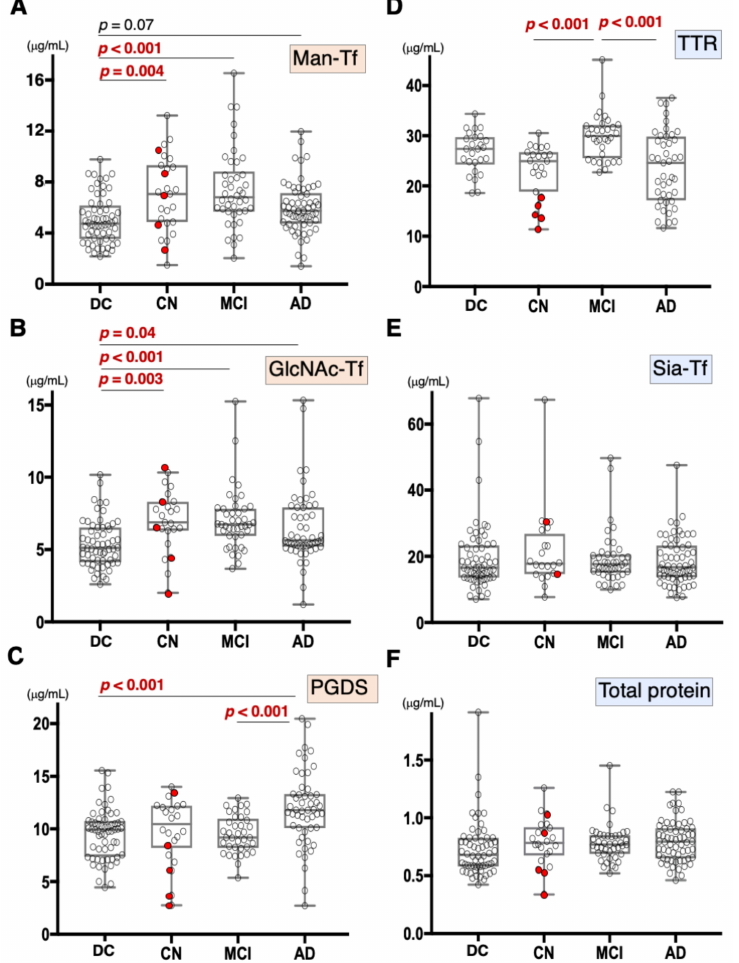
Figure 2. Box plots of CSF marker concentrations in CN, MCI, AD, and disease control (DC), which includes FTD, PSP, DLB, and PD: Man-Tf ( A ), GlcNAc-Tf ( B ), L-PGDS ( C ), TTR ( D ), Sia-Tf ( E ), and total protein ( F ). Horizontal lines within boxes show median values; boxes exclude upper and lower interquartile ranges; whiskers indicate the maximum and the minimum values. Five CN subjects who converted to MCI are indicated with red filled circles. Sia-Tf data from three conversion cases were not determined. Man-Tf data of disease control, MCI, AD is cited from our previous paper, reprinted with permission from ref. [15], 2021, Yasuhiro Hashimoto. Multiple comparisons were assessed by the Kruskal–Wallis method followed by Bonferroni correction. All combinations of clinical groups were assessed, and combinations showing significant difference were indicated with horizontal bars except that Man-Tf data between DC and AD ( p =